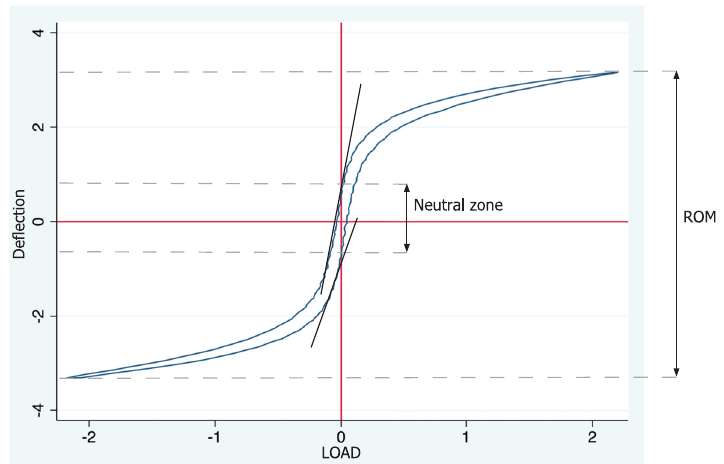
Figure 4. When load de fl ection data was plotted, two sigmoid curves were obtained, representing fl extion and extension movement. Range of movement was measured as the maximum loading in each direction. Difference in intersection with the zero bar of load indicates the neutral zone. Neutral zone stiffness is the slope at zero load.